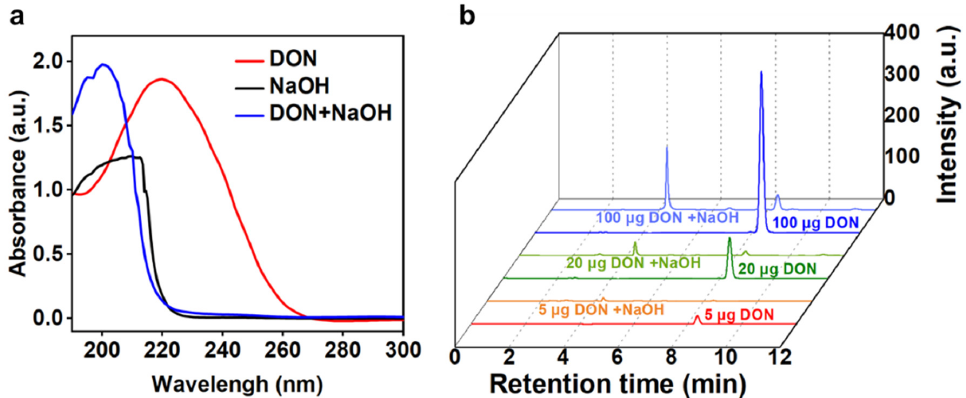
Figure 3. Characterizations of the DON variations in the simulated deacidification process in the aque- ous solution. ( a ) UV-vis absorption spectra of the DON or the solution of alkali treatment. ( b ) HPLC chromatogram spectra of the different amounts DON and the solutions after alkali